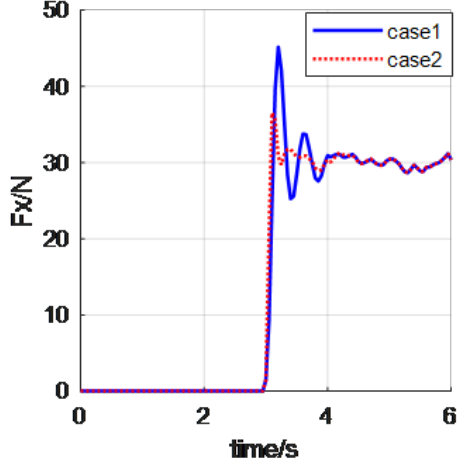
Figure 7. The contcact force.